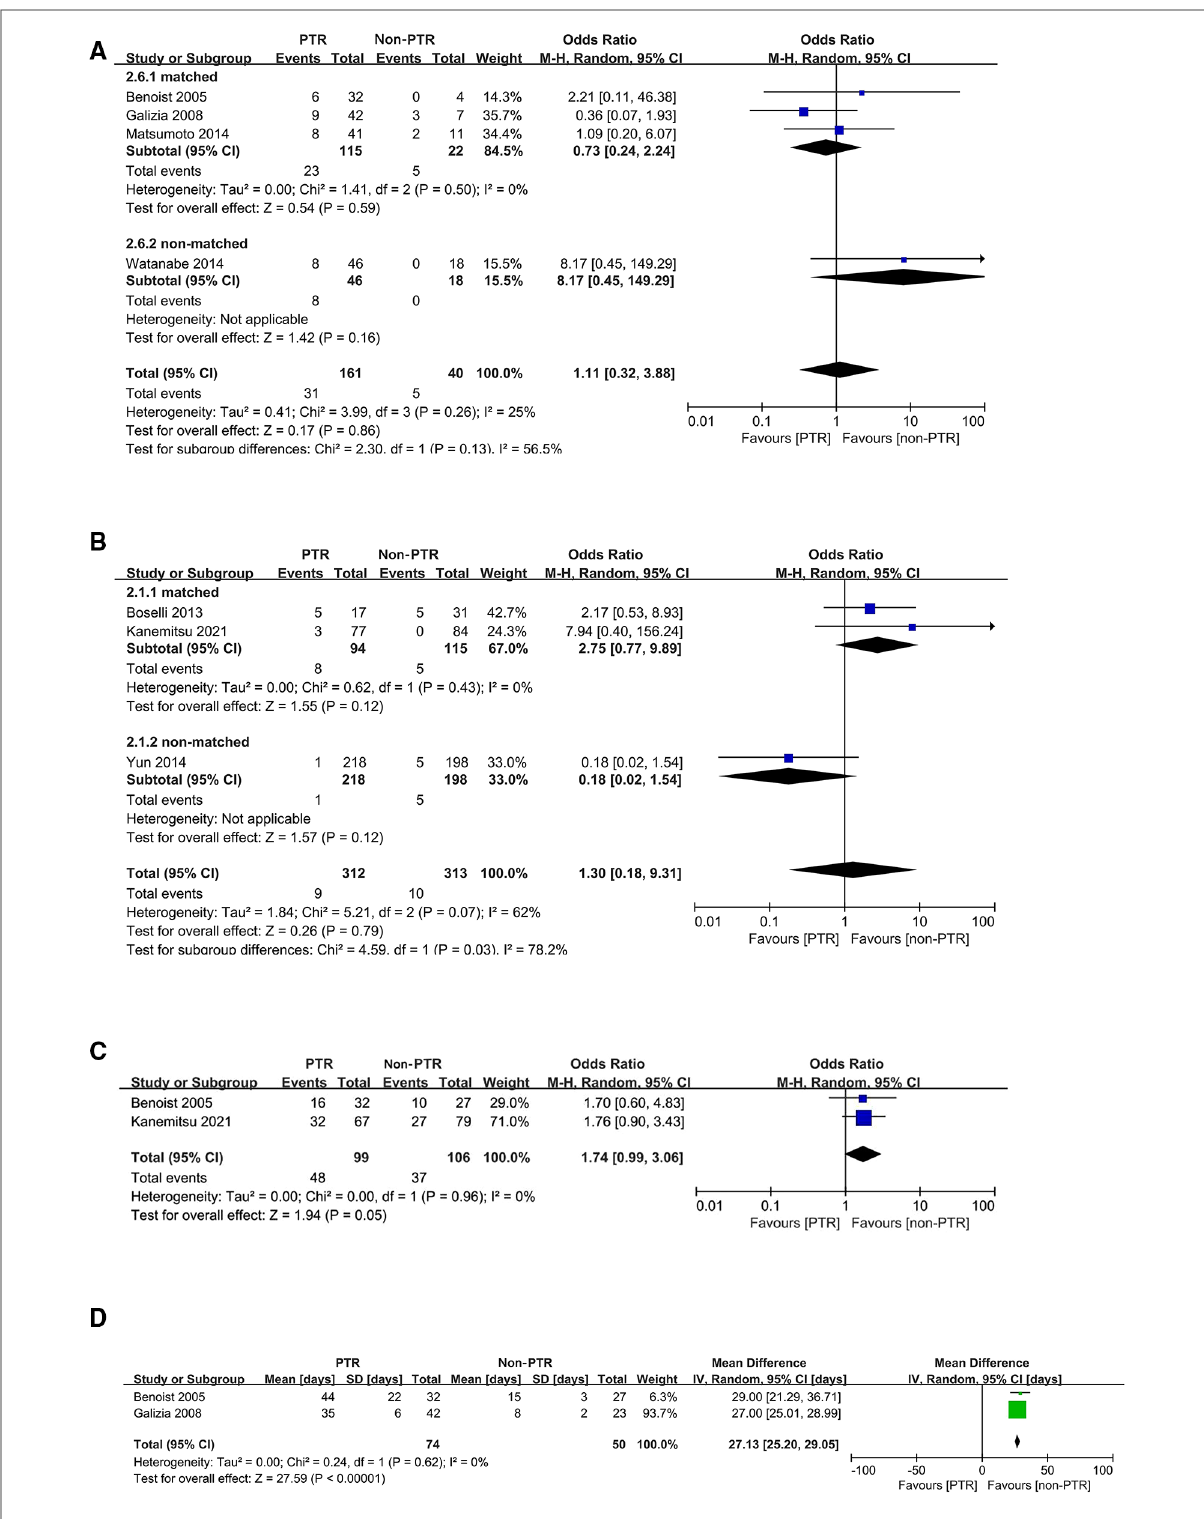
FIGURE 3 Forest plots for postoperative complications ( A ), 30-day mortality after upfront treatment ( B ), grade 3 or higher adverse effects due to chemotherapy ( C ), and interval from diagnosis to chemotherapy ( D